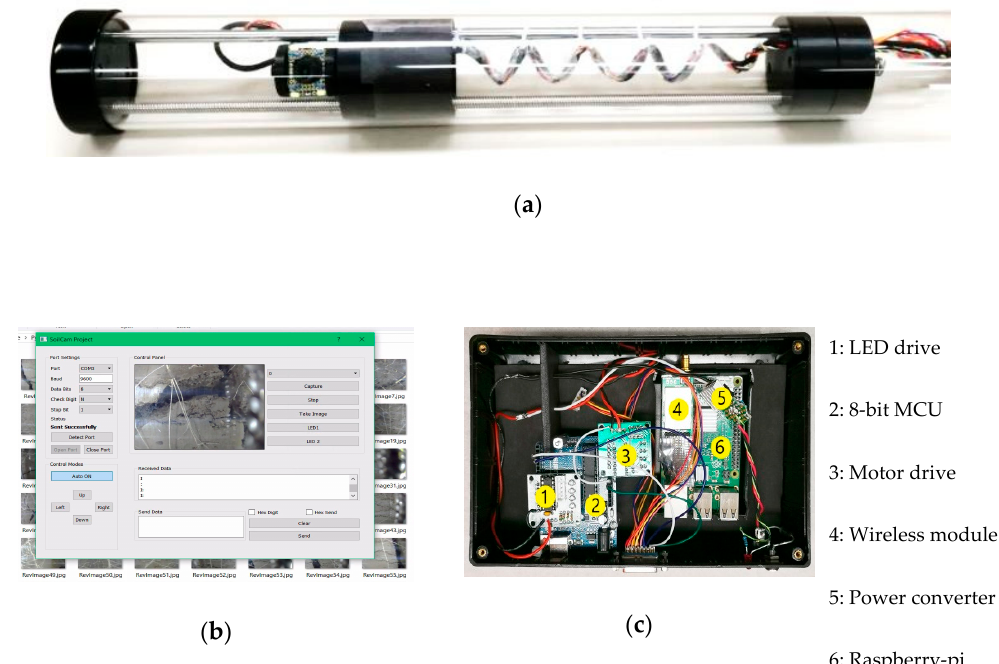
Figure 2. ( a ) Developed multimodal SoilCam in lab, ( b ) integrated root/soil analyzer and control software, and ( c ) control box